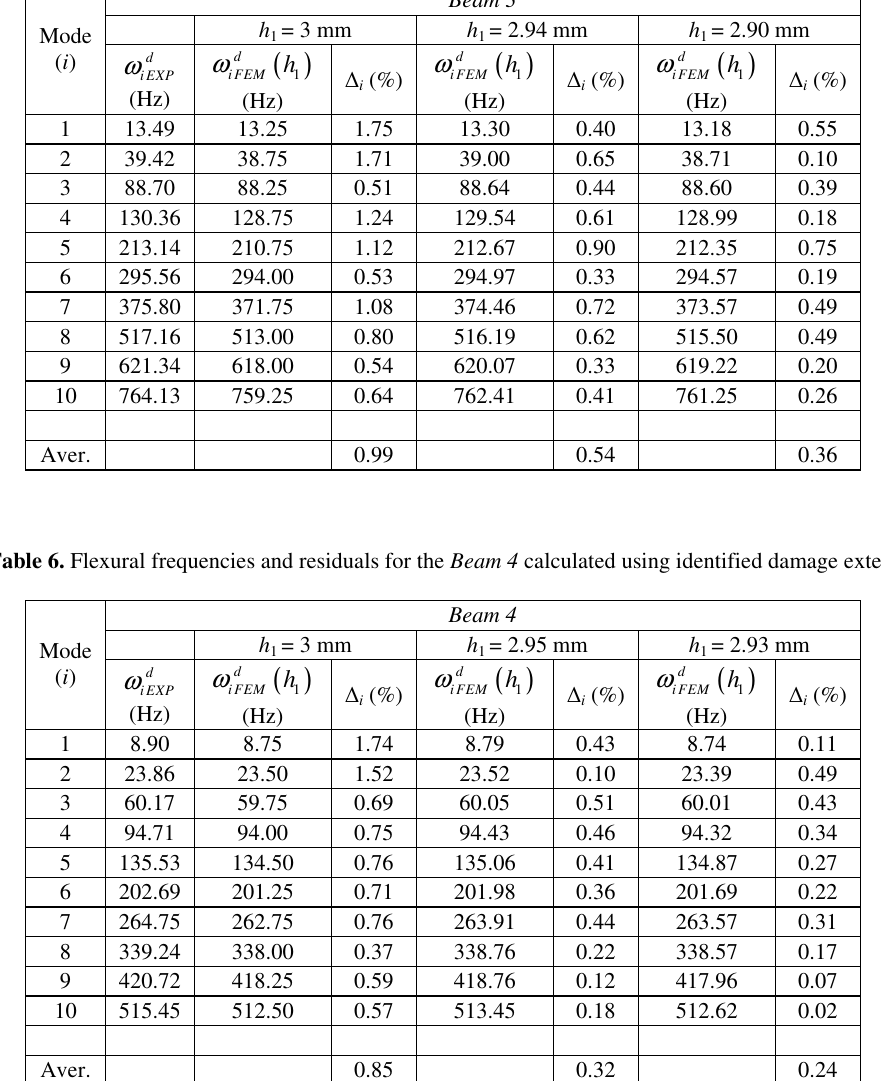
Table 5. Flexural frequencies and residuals for the Beam 3 calculated using identified damage extent